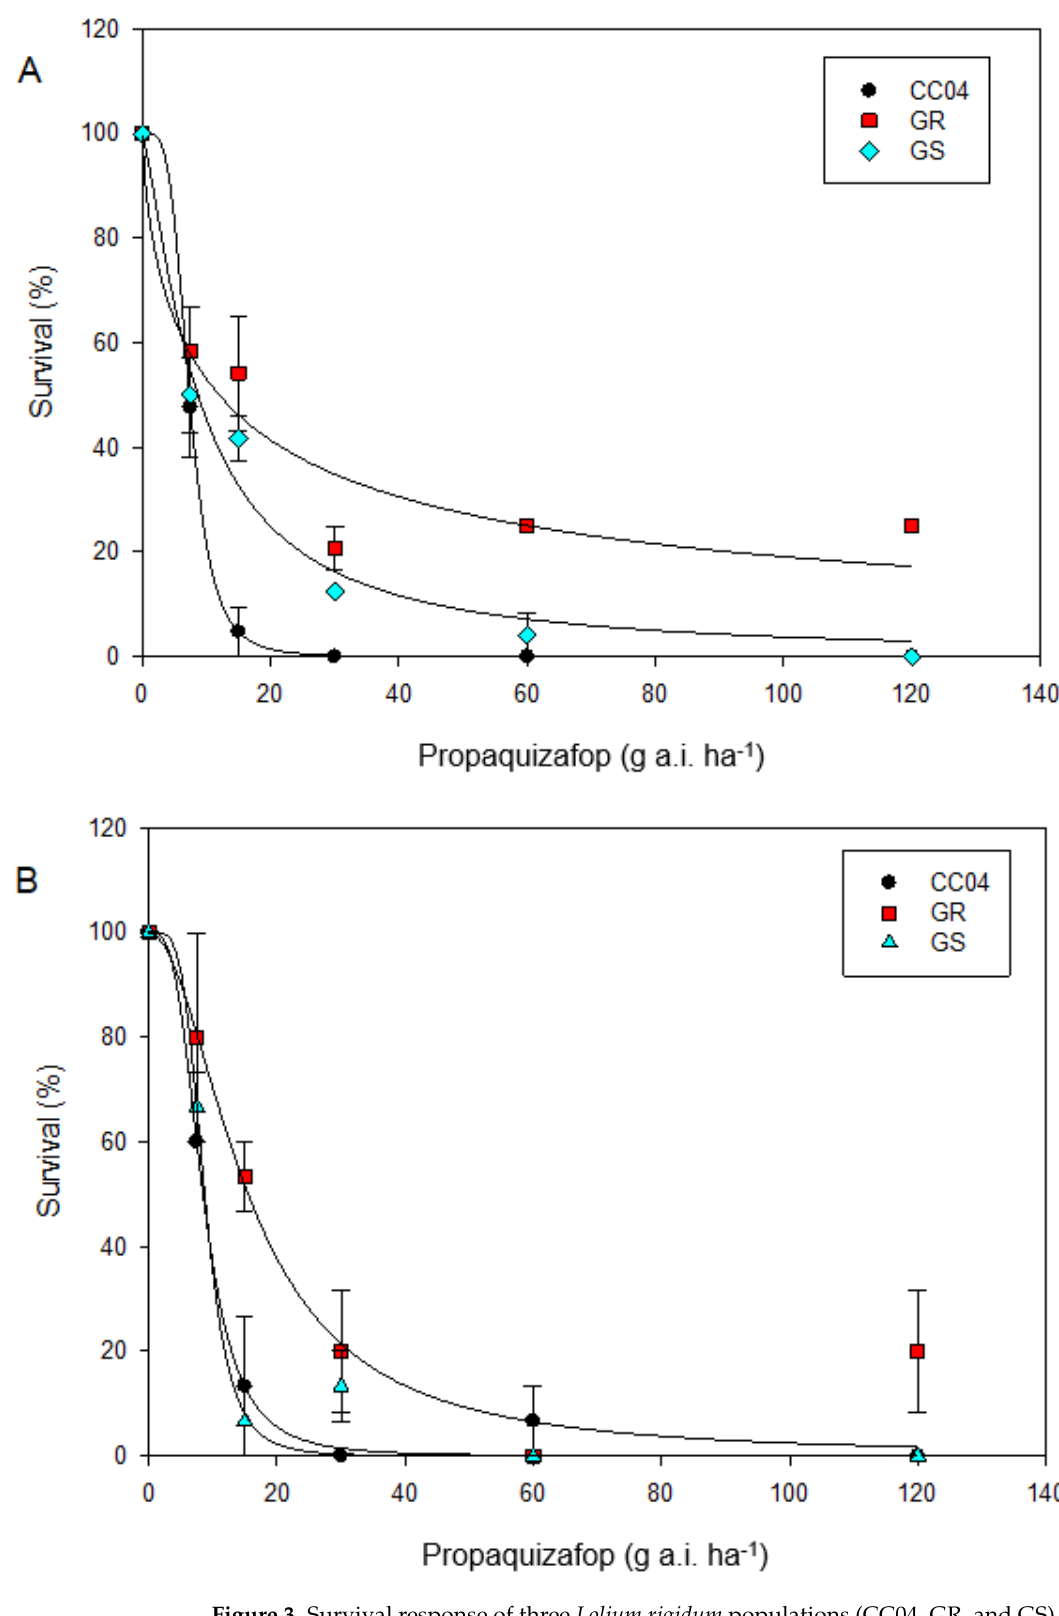
Figure 3. Survival response of three Lolium rigidum populations (CC04, GR, and GS) to six rates of propaquizafop in ( A ) 2019 and ( B ) 2021. Data are presented as the average percentage of plants that survived and error bars represent the standard error of the mean.